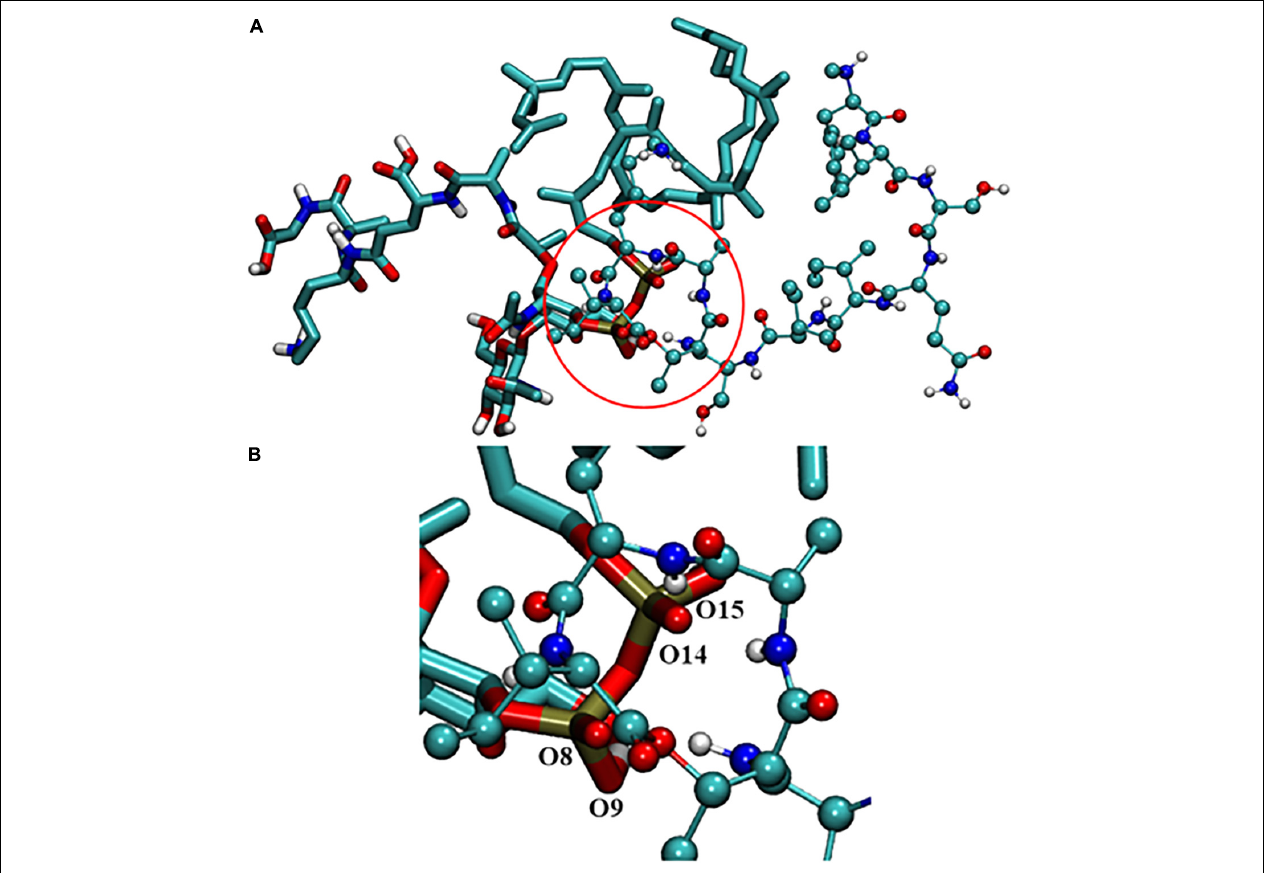
FIGURE 4 | (A) Interaction between lipid II and Lys10-teixobactin (4); (B) magnification of the pyrophosphate and the cycle. For clarity purposes, only polar hydrogens were